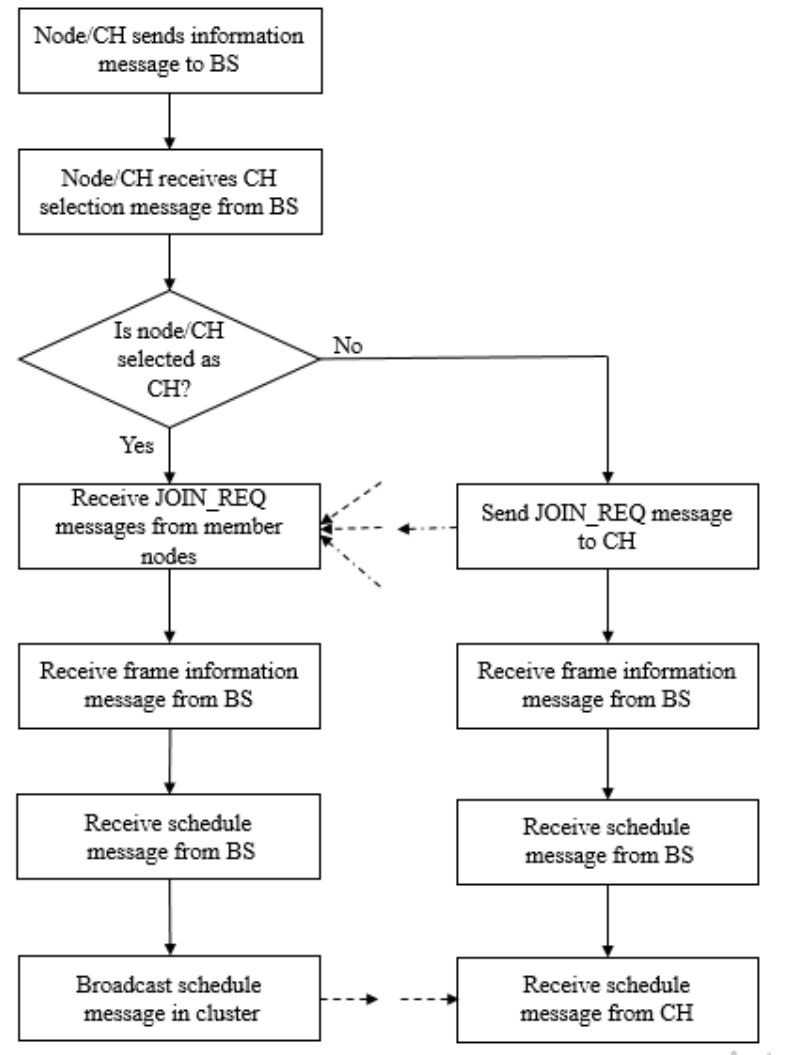
Figure 3. Setup Phase in Proposed Model.